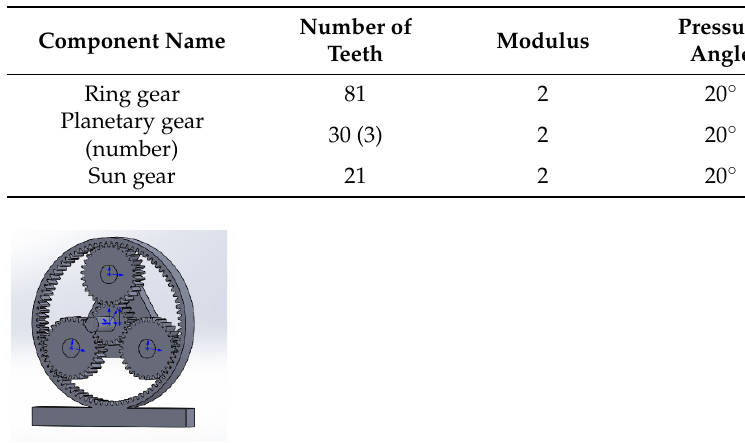
Table 1. Parameters related to teeth-containing components.